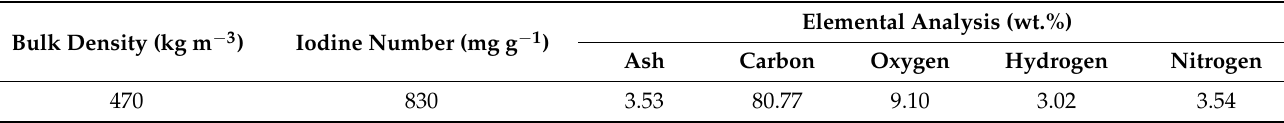
Table 2. Physicochemical characteristics of the RSAC sample.